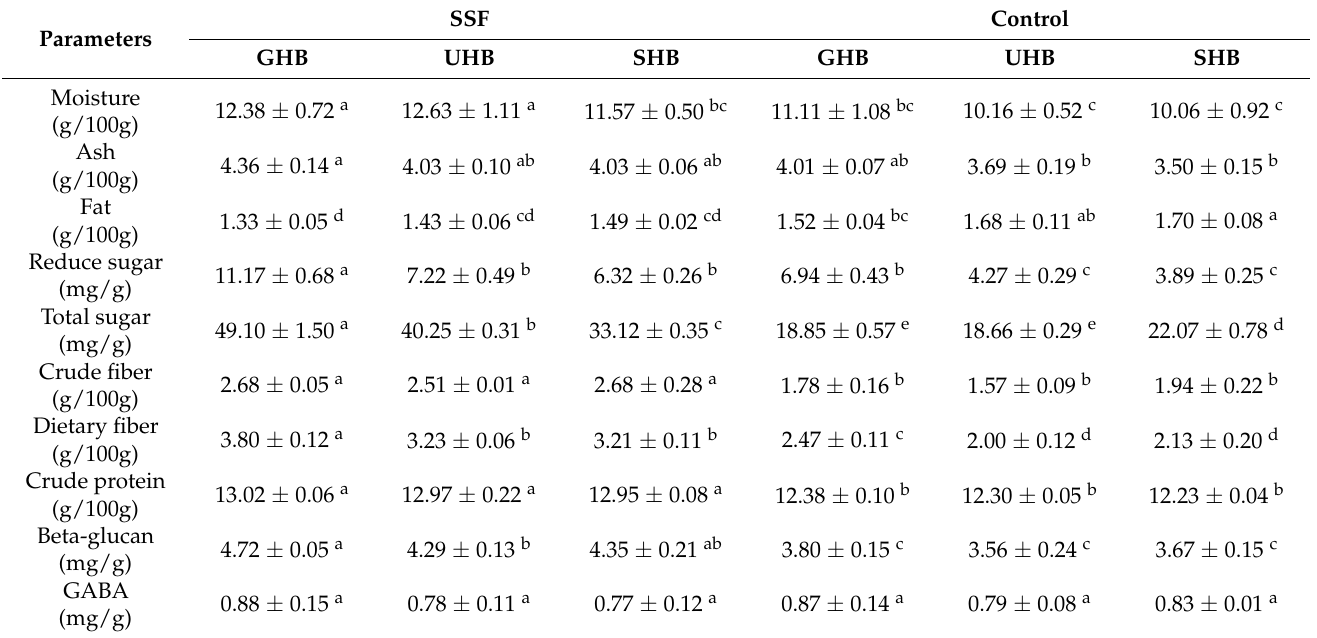
Table 1. Nutritional constituents (dry matter) of the highland barley (the control groups and colonized groups with the mycelia of A. sinodeliciosus var. Chaidam ZJU-TP-08).